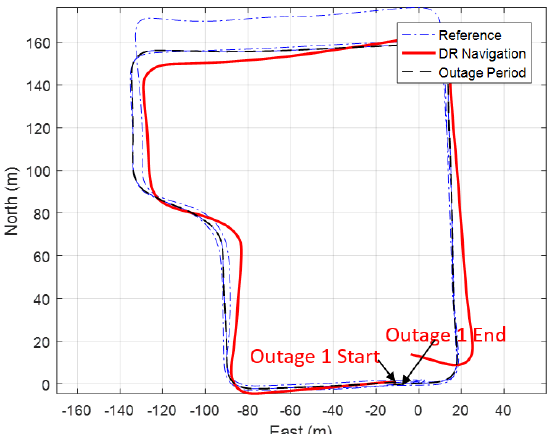
Figure 12. DR trajectory for 90 seconds GNSS signal outage